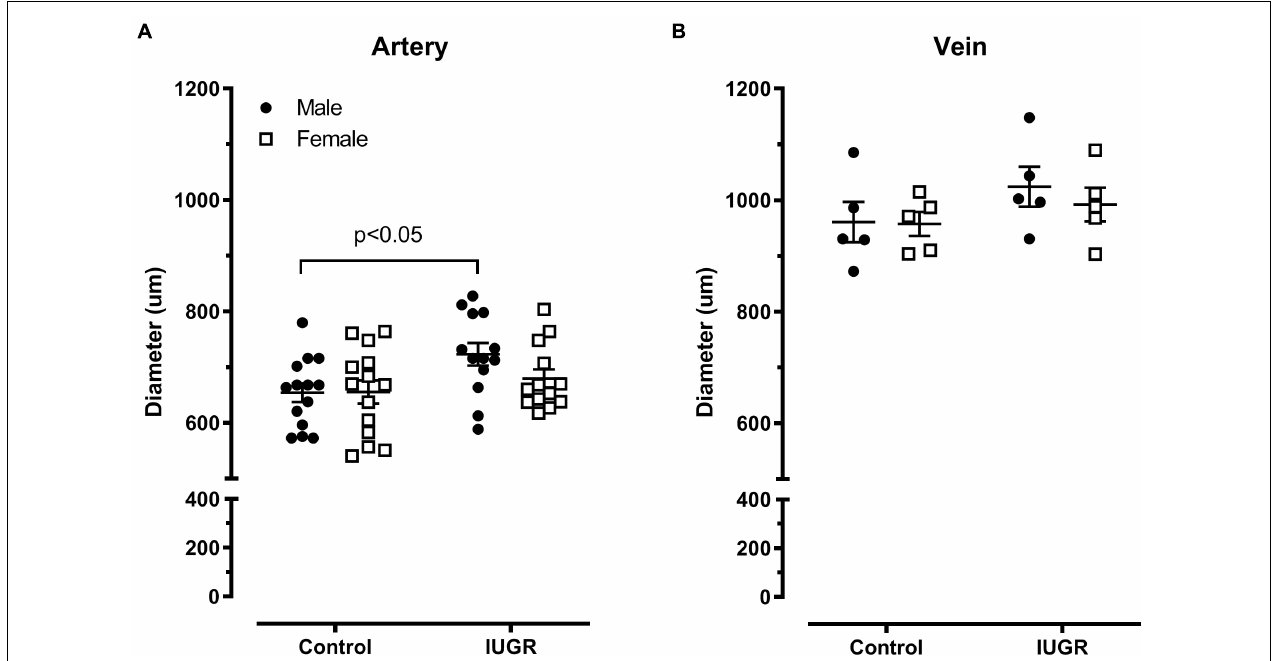
FIGURE 5 | Umbilical artery (A) and vein (B) passive diameter in micrometer ( µ m) for the different groups of animals. Control ( n = 14), IUGR ( n = 13). Lines represents mean ± SEM.